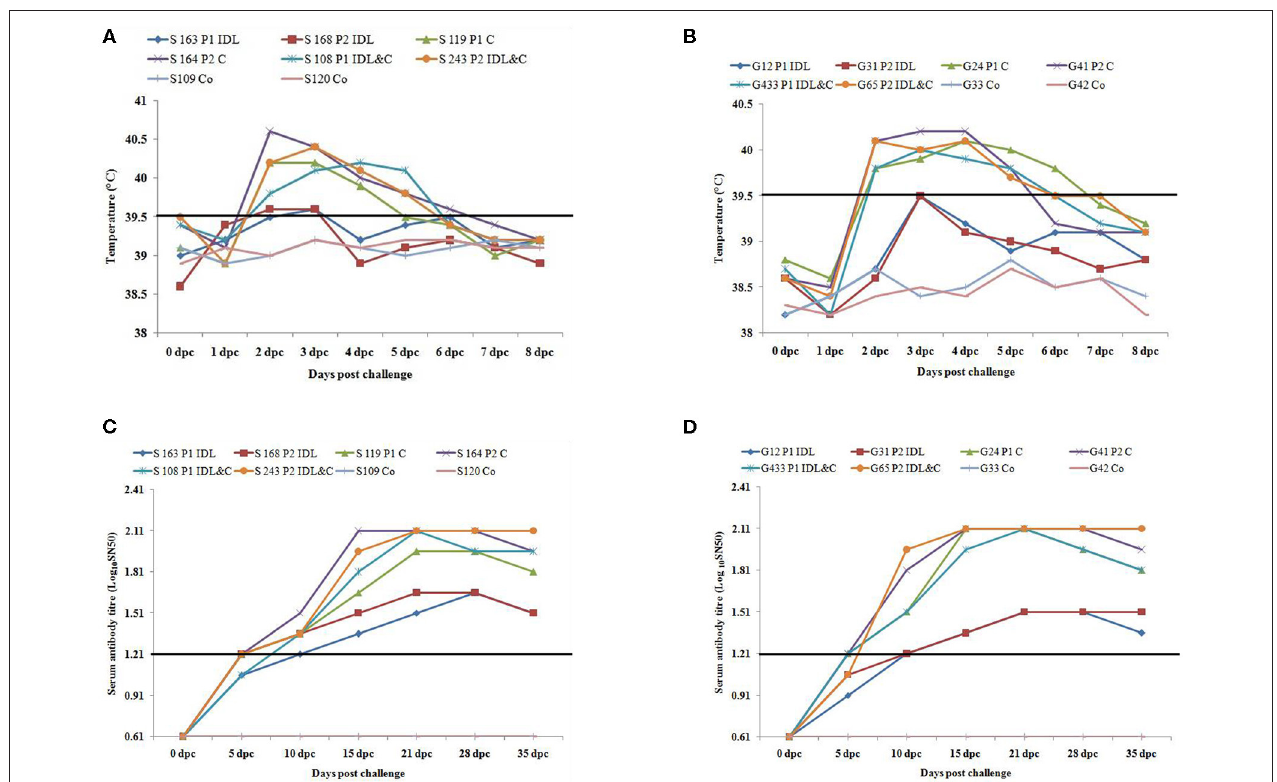
FIGURE 1 | (A) Rectal temperature ( ◦ C) of challenged (intra-dermo-lingual (IDL), coronary band (C) and by both route) and control sheep. P1, passage 1; P2, Passage 2. Solid line indicates normal temperature of sheep. (B) . Rectal temperature ( ◦ C) of challenged (intra-dermo-lingual (IDL), coronary band (C) and by both route) and control goats. P1, passage 1; P2, Passage 2. Solid line indicates normal temperature of goats. (C) Virus neutralization titres of challenged and control sheep (Expressed as the log10 reciprocal antibody dilution required for 50% neutralization of 100 tissue culture infectious units). Solid line indicates neutralizing antibody titre > 1.2 log 10 SN50 is considered positive. (D) Virus neutralization titres of challenged and control goats (Expressed as the log10 reciprocal antibody dilution required for 50% neutralization of 100 tissue culture infectious units). Solid line indicates neutralizing antibody titre > 1.2 log 10 SN50 is considered positive.